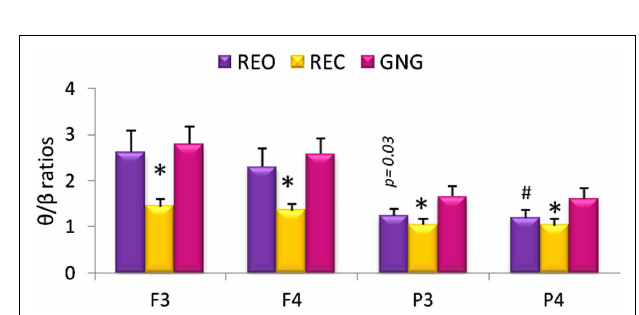
band power was lower during REC compared to REO and GNG. # For all (A–D) electrodes relative α band power was higher during REC than REO and GNG. @ Parietal electrodes (C,D) β band power was lower during REC than REO and GNG and † higher during REO compared to GNG ( p < 0.02, n = 53, mean ± SEM).